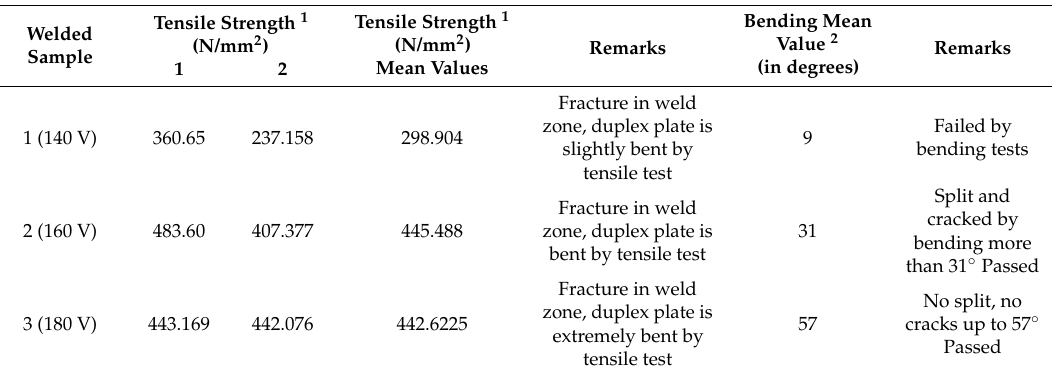
Table 5. Tensile and bending test results.